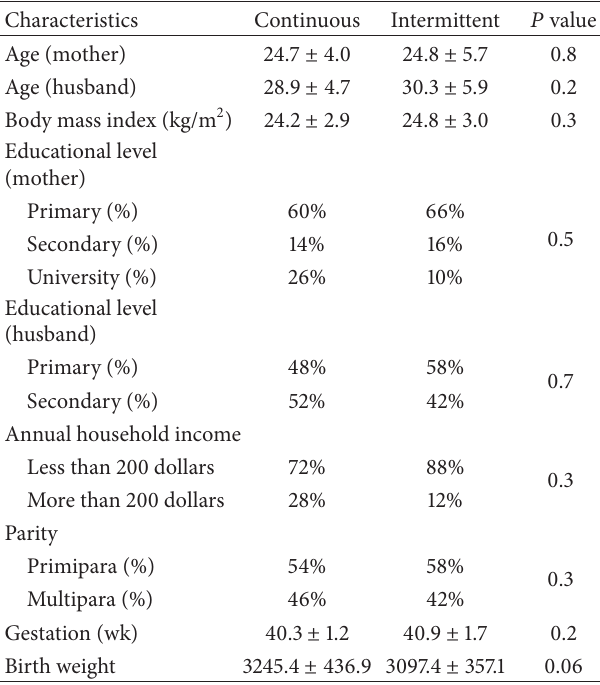
Table 1: Demographic characteristics of the